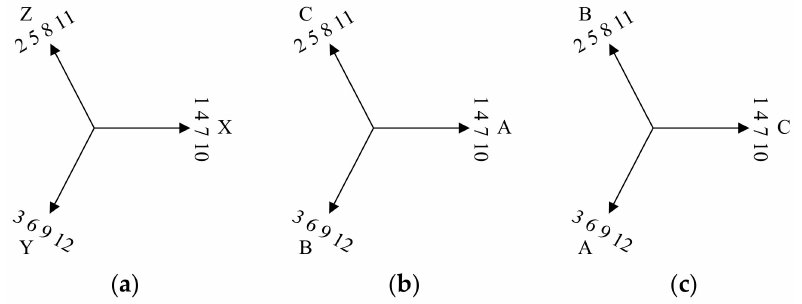
Figure 13. Slot electrical potential star vectograms of the 120 ◦ -TWDSPMLSM. ( a ) Upper conductors,